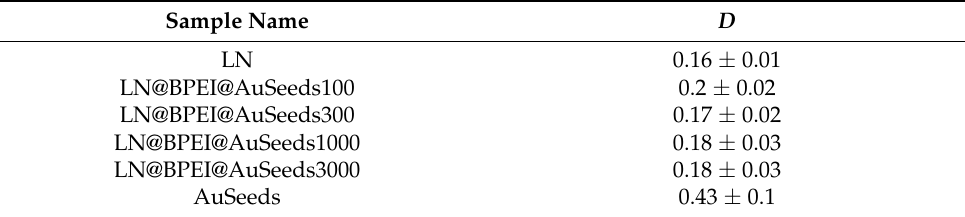
Table 3. Depolarization ratios for the core LN, AuSeeds and different LN@BPEI@AuSeeds